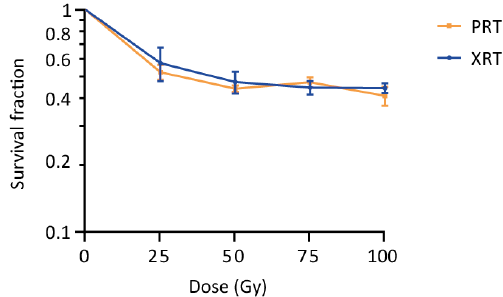
Figure 1. Survival of wild type yeast after proton (PRT) and photon radiotherapy (XRT). Survival of a wild type yeast strain (KV447) after PRT and XRT was determined using plating assays. Survival fractions were calculated and a survival curve was plot on a logarithmic scale. Data are represented as the mean ± SEM for n = 3. p -values were calculated by multiple t-testing per dose, but no significant differences were detected ( p -values of 0.66, 0.60, 0.56 and 0.50 were calculated at 25 Gy, 50 Gy, 75 Gy and 100 Gy,